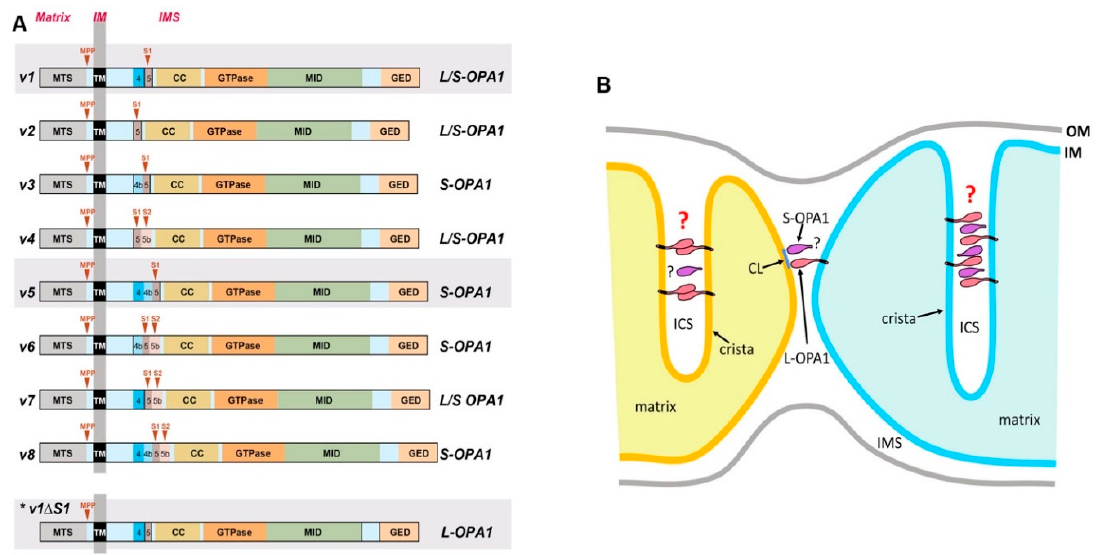
Figure 3. OPA1 variants and operating models for IM fusion and cristae width maintenance. ( A ) Eight different OPA1 variants. Cleavages at S1 and S2 generate S-OPA1. OPA1-v3, v5, v6, v8, which contain the region encoded by exon 4b, are cleaved completely to generate only S-OPA1. The cleavage in the other four variants is incomplete, generating both L- and S-OPA1 (L/S-OPA1). OPA1-v1 ∆ S1 (*) is an experimentally generated mutant in which the S1 site is deleted in the OPA1-v1 variant, and thus forms only L-OPA1. OPA1-v1, v5, and v1 ∆ S1 (shaded) were used as representatives for L/S-, S-, and L-OPA1, respectively, in our study [96]. MPP, mitochondrial processing peptidase. ( B ) IM anchored L-OPA1 binds to CL of opposing IM for tethering and subsequent fusion, and S-OPA1 may facilitate this process. Cristae tightness may be maintained by trans-interaction of L-OPA1 (left crista) or by L-OPA1 oligomerization that is facilitated by S-OPA1 functioning as molecular staples (right crista). However, these models have recently been challenged by a new finding that S-OPA1 can maintain cristae tightness.